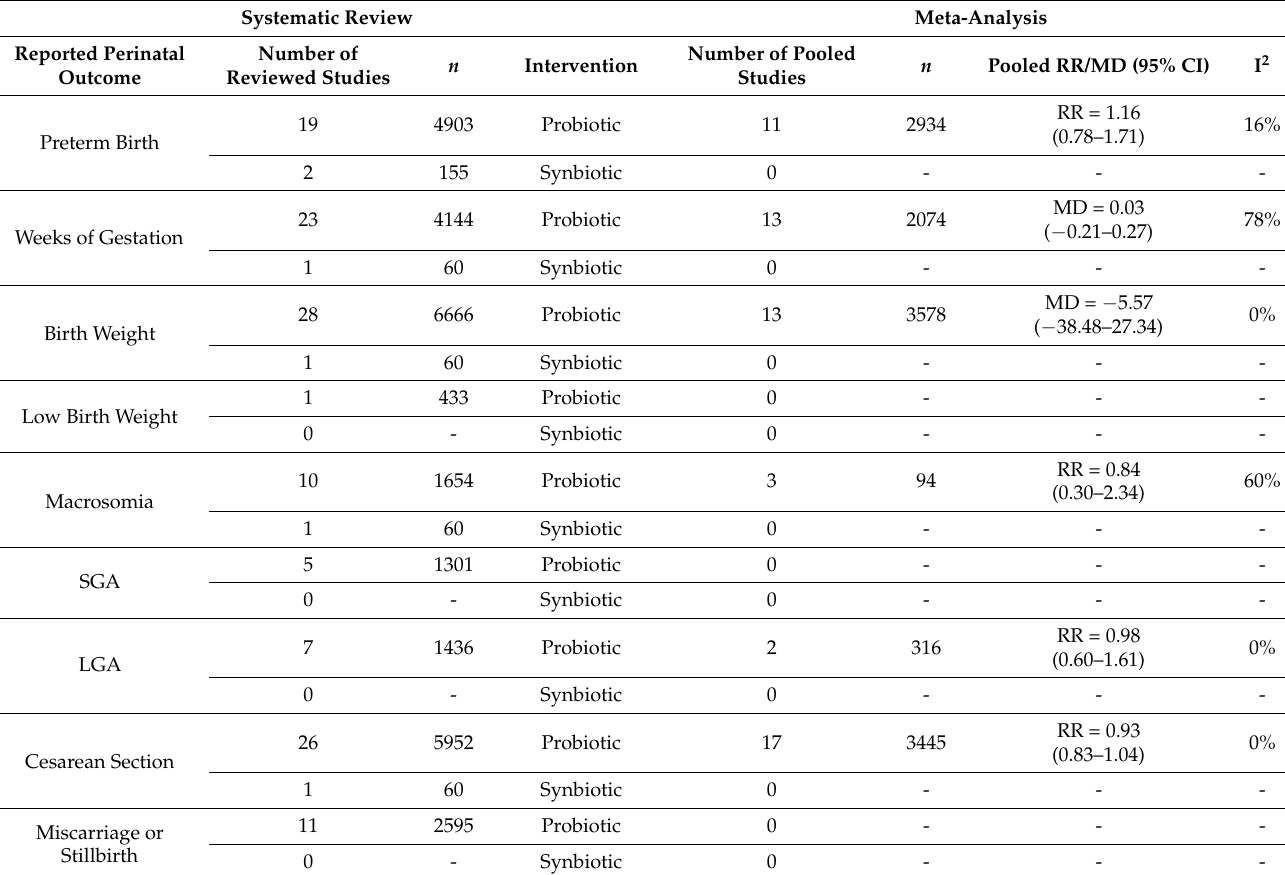
Table 2. Summary of included studies bases on the reporting of perinatal